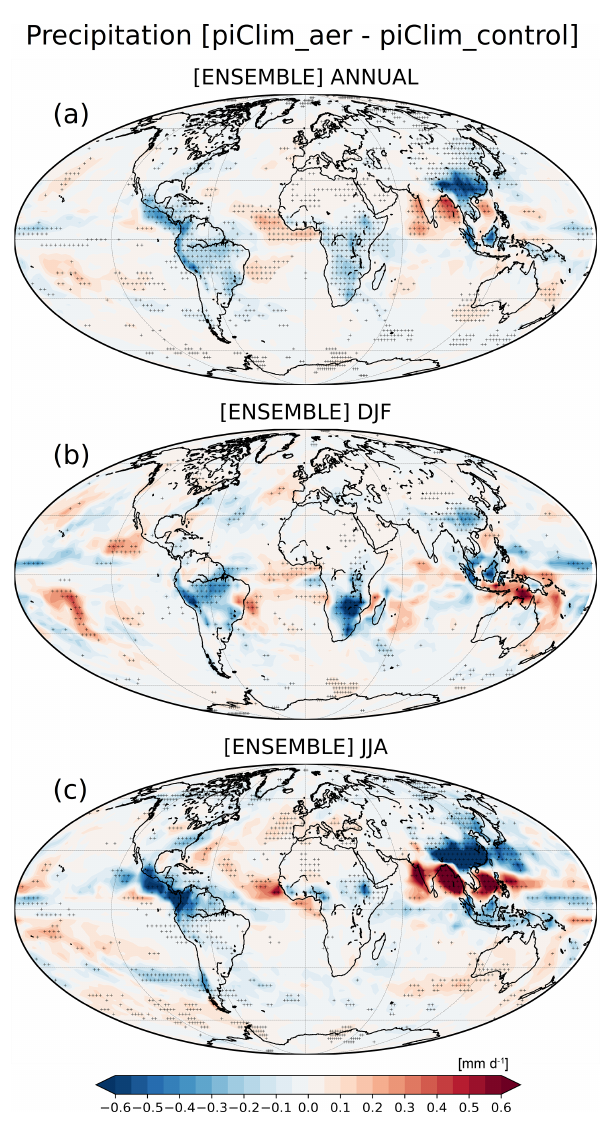
Figure 8. Differences between piClim-aer and piClim-control in precipitation (mmd − 1 ) for the ensemble of 10 models (a) on an annual basis, (b) for DJF and (c) for JJA. The dot shading indicates areas in which the differences are statistically significant at the 95% confidence